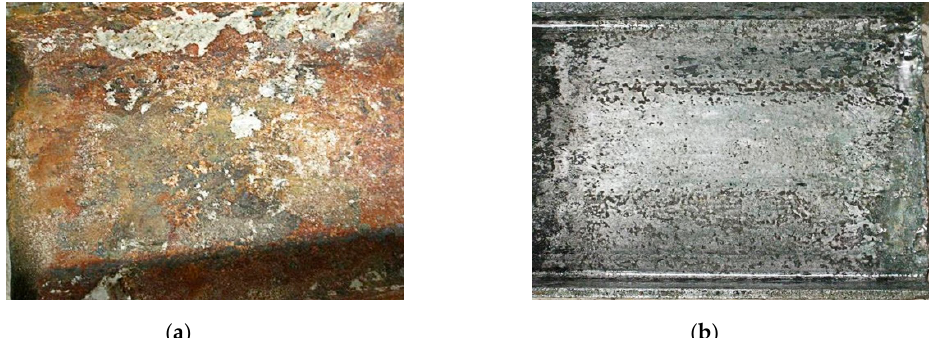
Figure 3. The state of I-shaped steel. ( a ) I-shaped steel after corrosion; ( b ) I-shaped steel after corrosion rust removal.